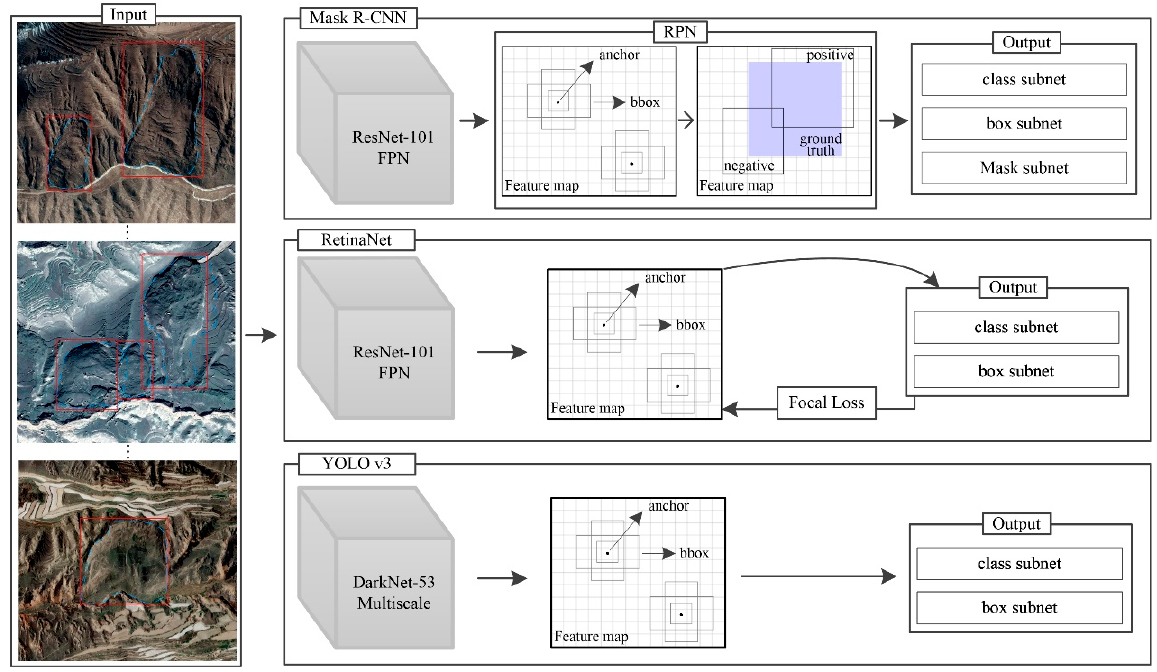
Figure 3. Flowchart of object detection model used for landslide detection.